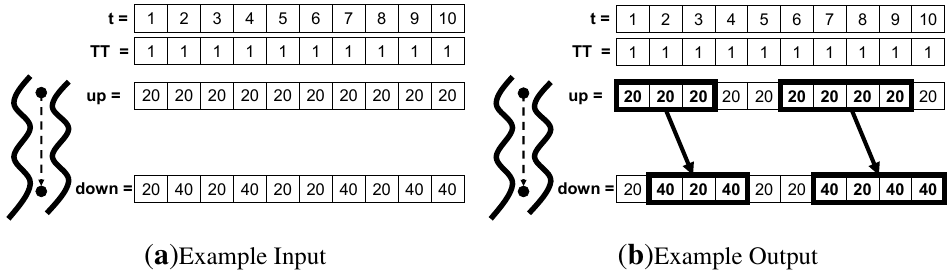
Figure 3. Flow Anomaly Example. ( a ) Example input. ( b ) Example